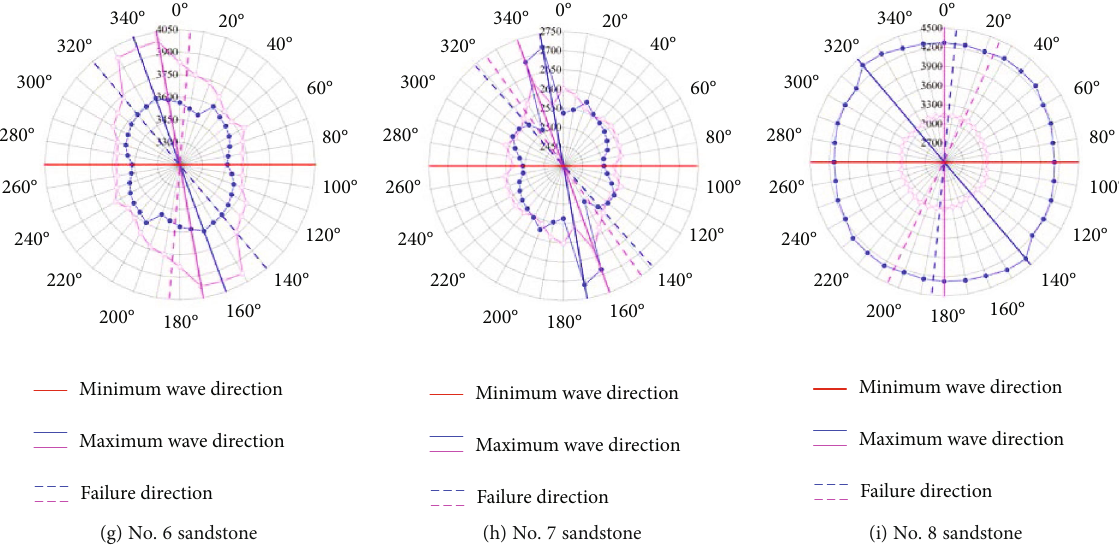
Figure 6: P wave velocities of sandstone, in which the blue line represents the maximum wave velocity direction and the red line represents the minimum wave velocity direction.